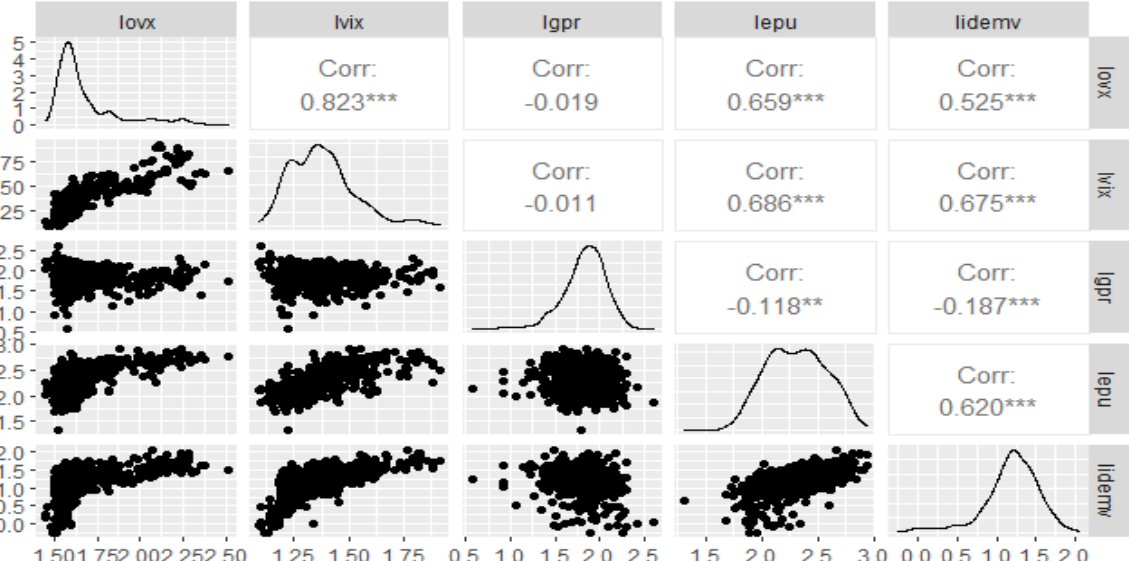
Figure 2. A correlation analysis during COVID-19. Notes: (**) Significant at the 5%; and (***) Significant at the 1%.